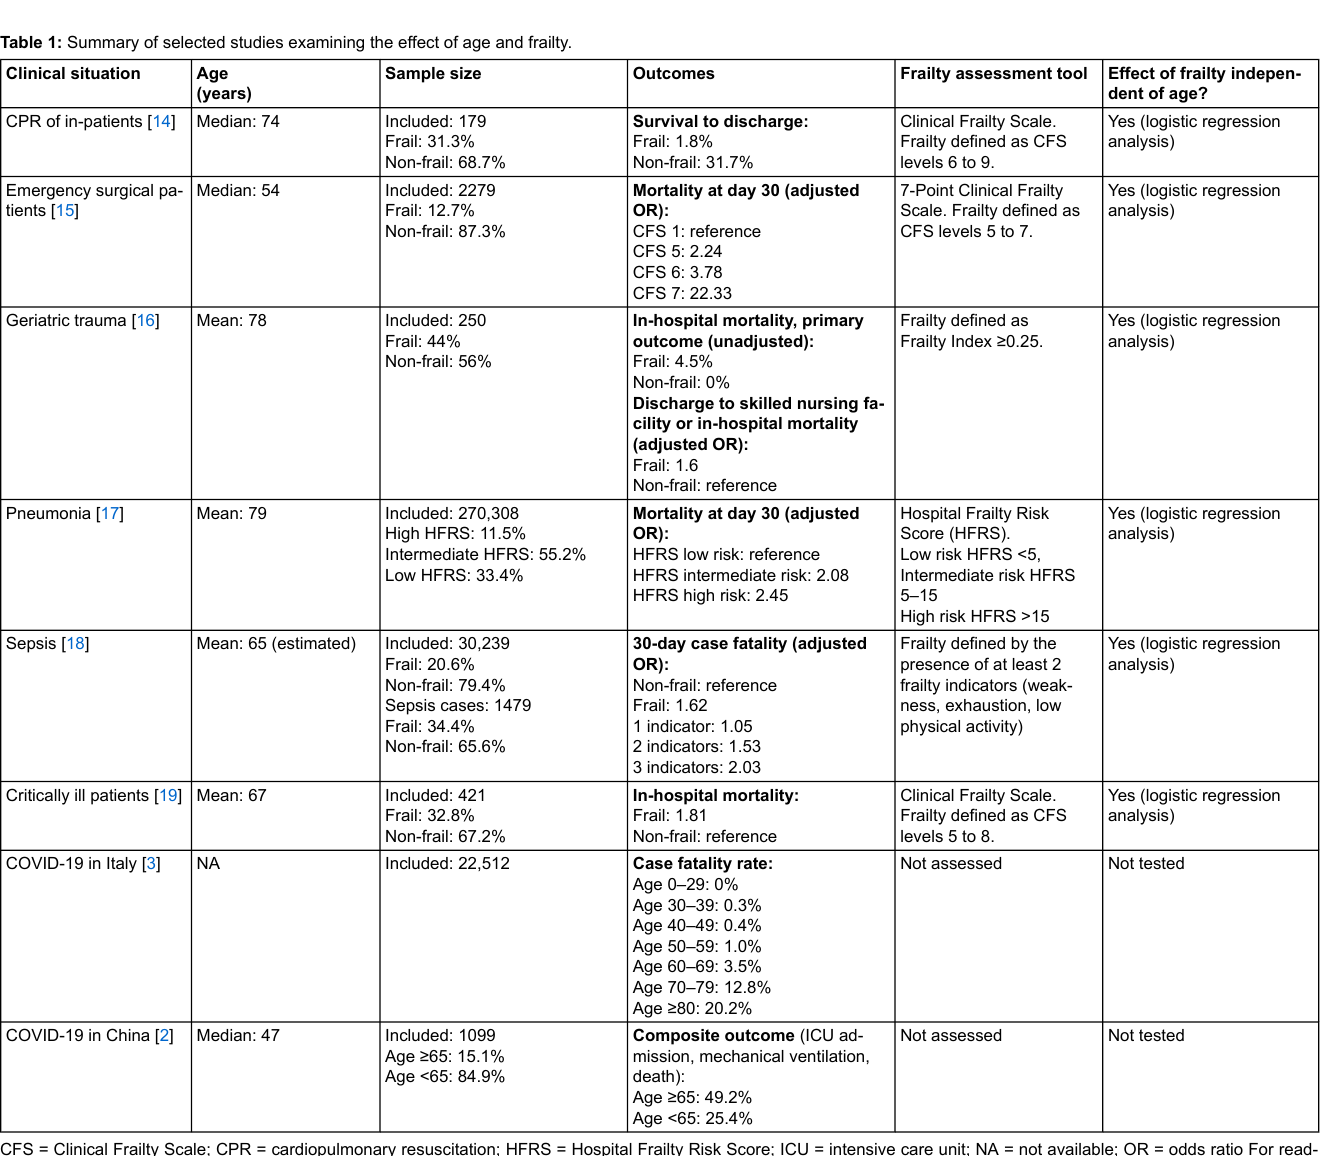
Table 1: Summary of selected studies examining the effect of age and frailty. Clinical situation